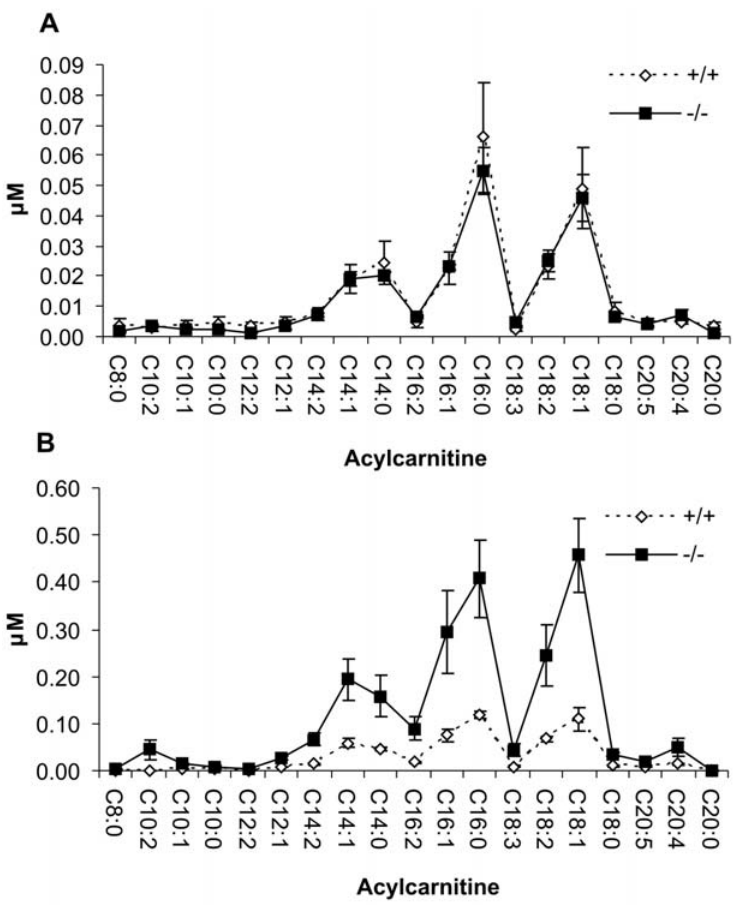
Figure 7. Serum acylcarnitine analysis under normal and fasted conditions. Serum acylcarnitines were analyzed for wild type (solid line) and Decr 2 / 2 mice (dotted line) by mass spectrometry. (A) Serum acylcarnitine profile under normal conditions, as determined from the mass spectral data. (B) To determine the serum acylcarnitine profile under fasted conditions mice were subjected to a 24 h fast prior to serum collection. The concentrations of acylcarnitine are expressed as means 6 SE of 5–6 mice of each genotype per group.